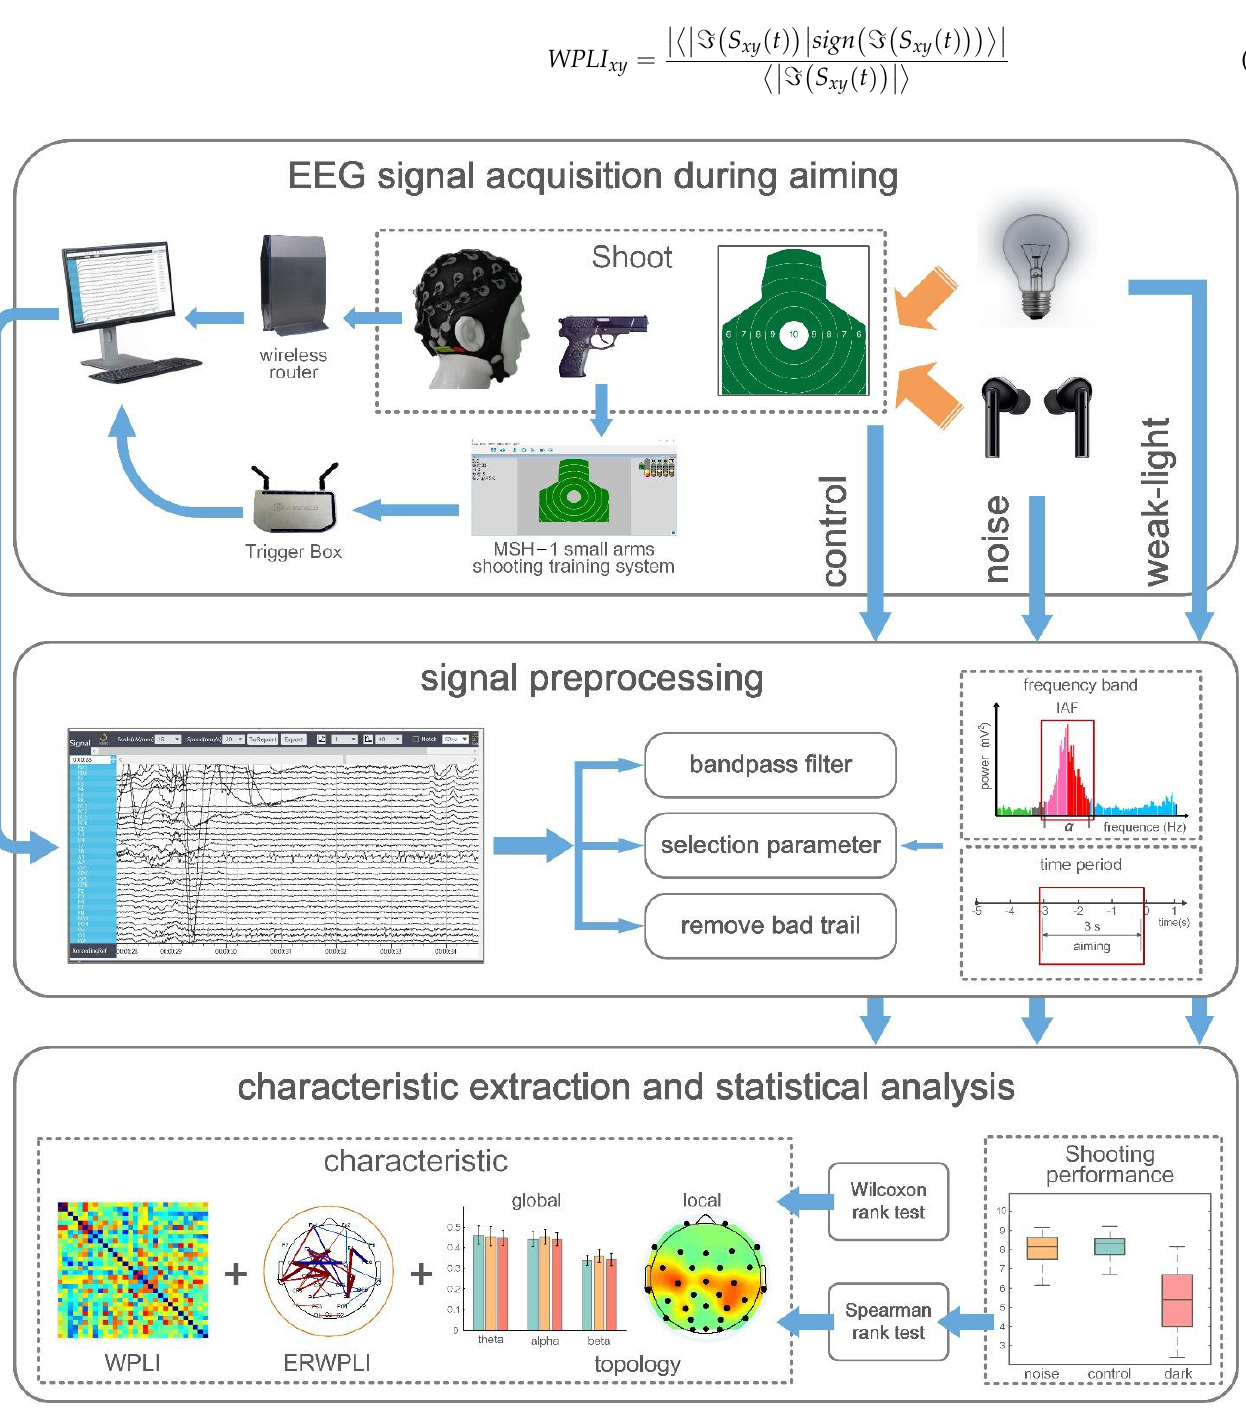
Figure 1. The experimental analysis process.